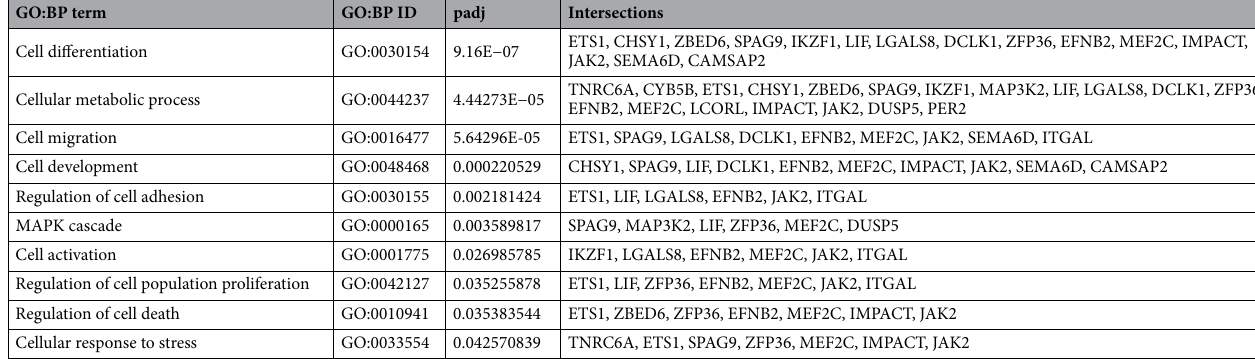
Table 1. Integrated miRNA-mRNA network analysis. GO-BP database analysis of central network genes (Degree > 3, Betweenness centrality > 100) was performed using g:Profiler with g:SCS multiple testing correction method. Each term identified in the table are among those significantly enriched (padj > 0.05) with important impacts on intestinal barrier integrity.